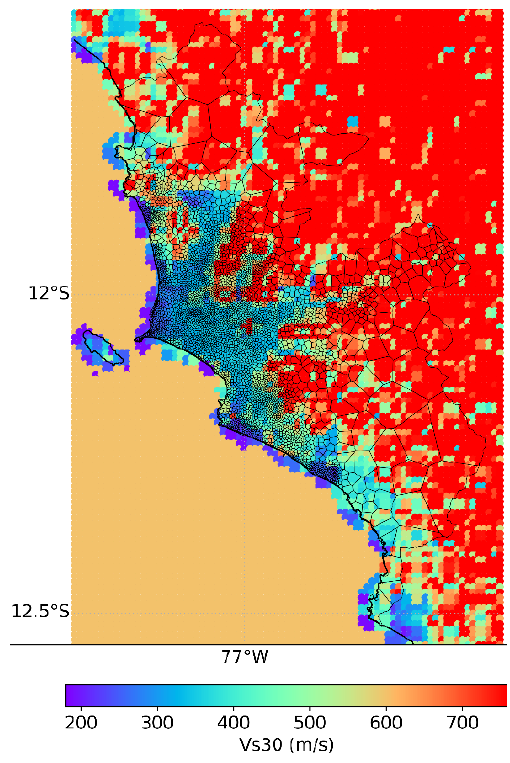
Figure 7. Spatial distribution of Vs 30 values in Callao–Lima as re- ported by Ceferino et al. (2018b) enclosed within the CVT-based model